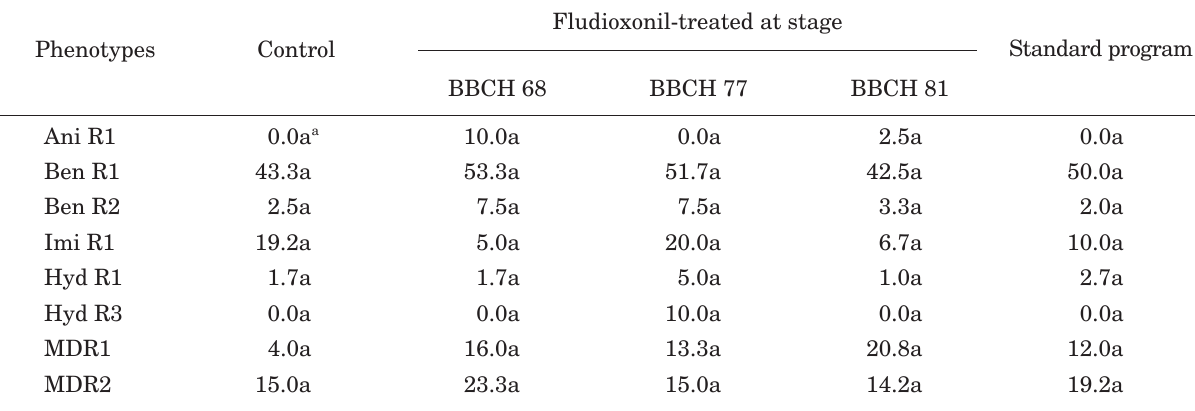
a values followed by the same letter are not statistically different at the 5% level by aNova followed by a Student’s t test.